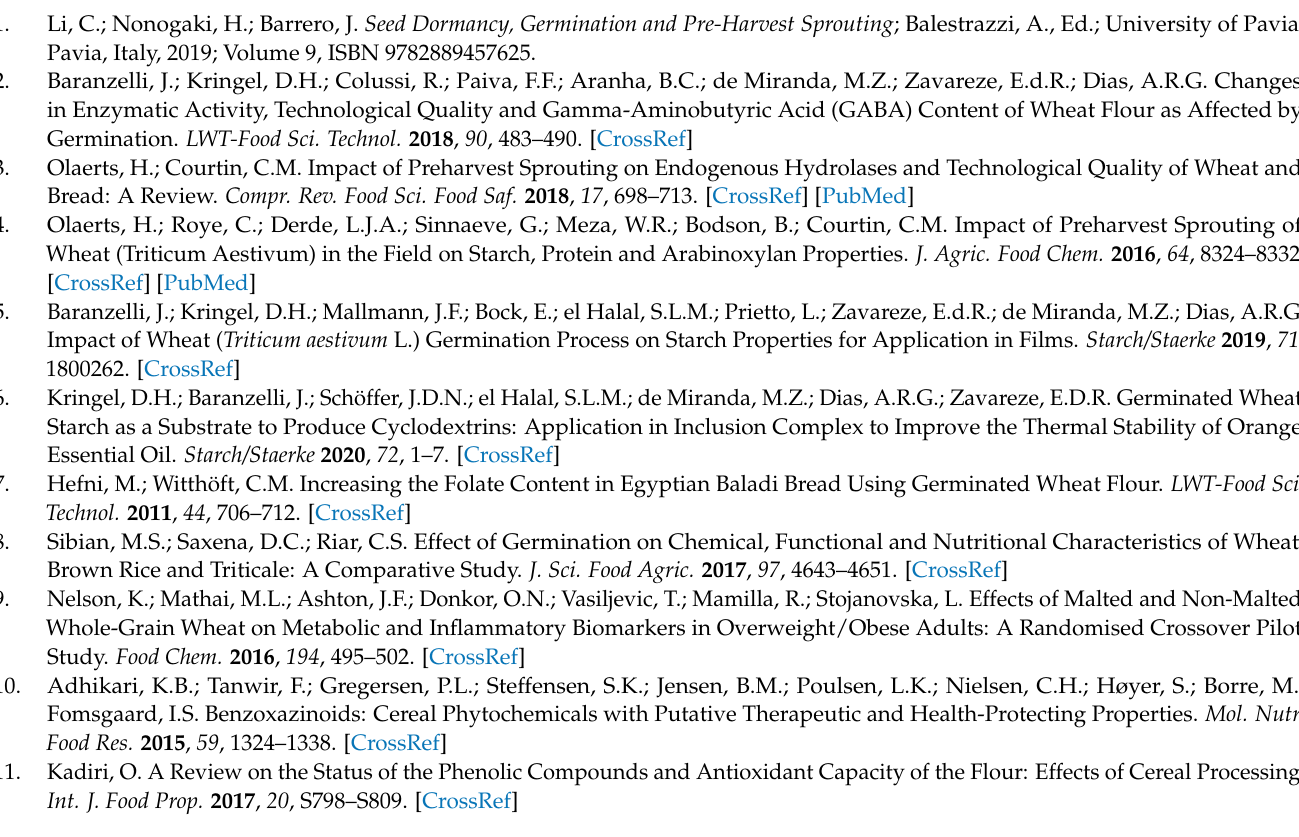
Table S2. Grain images during germination. Figure S1. Representative LC-PDA chromatograms of phytochemicals extracted from wheat grains. Free compounds (a) and bound compounds obtained by alkaline (b) and acid (c) hydrolysis. Table S3. Tentative identification of wheat phytochemicals by LC- Q-TOF-MS and LC-Orbitrap-MS. Table S4. Results of multivariate analysis of variance (MANOVA) for phytochemical compounds from wheat cultivars (C) under different germination times (T), using likelihood ratio test (Wilks) and Pillai, Hotelling-Lawley and Roy’s tests. Box S1. Validation data for the analysis of benzoxazinone and phenolic compounds. Table S5. Accuracy test for the analysis of phenolic and benzoxazinoid compounds in wheat